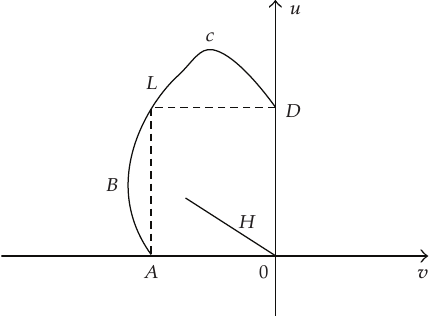
Figure 8: Relative position of curves L and H